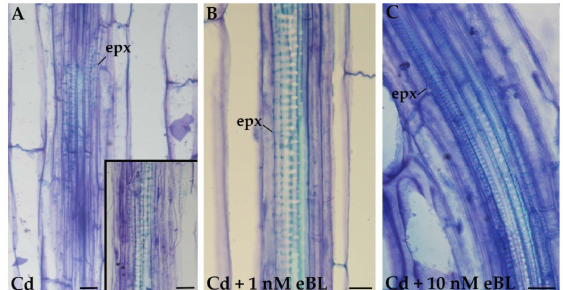
Figure 3. Xylogenesis in the basal hypocotyl of A. thaliana (Col ecotype) seedlings cultured for 9 days under continuous darkness followed by 7 days under 16 h light/8 h darkness photoperiod with different treatments. Ectopic protoxylem (epx) elements formed in the 60 µ M CdSO 4 (Cd) treatment ( A ), and reduced pericycle cell proliferation in the same treatment ( Inset ). ( B , C ) Production of only epx elements with 60 µ M Cd + 1 nM of 24-epibrassinolide (eBL) ( B ) or with 60 µ M Cd + 10 nM eBL ( C ). epx; ectopic protoxylem. Radial longitudinal sections stained with toluidine blue. Bars = 10 µ